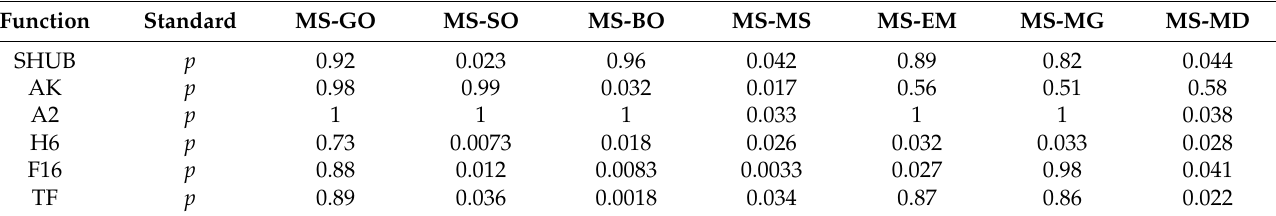
Table 3. Nonparametric statistical tests of MSMEIC.